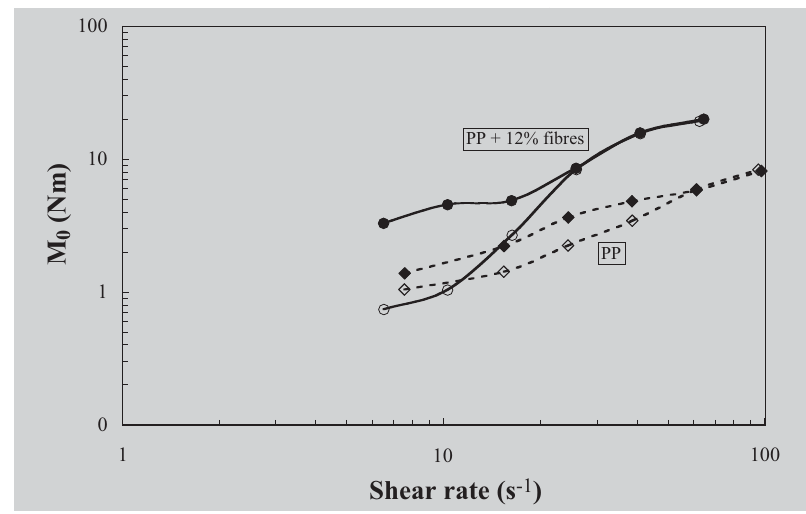
Figure 8: Torque corresponding to entry effects at beginning (full symbols) and end (open symbols) of mixing section for the same study of Figure